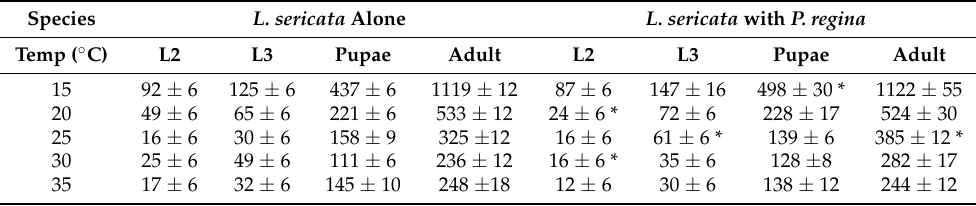
Table 1. Mean minimum development times (h) to reach each life stage starting from 1 h old first instar larvae for L. sericata when developing with conspecifics ( L. sericata alone) and heterospecifics ( L. sericata with P. regina ). Variation around the mean is presented as the greater of either half the sampling interval (6 h for second instar to pupal stages, 12 h for adult stage) or the calculated standard error. Asterisk * indicate differences ( p < 0.003) between L. sericata alone or with P. regina combinations within a single stage and temperature pairwise